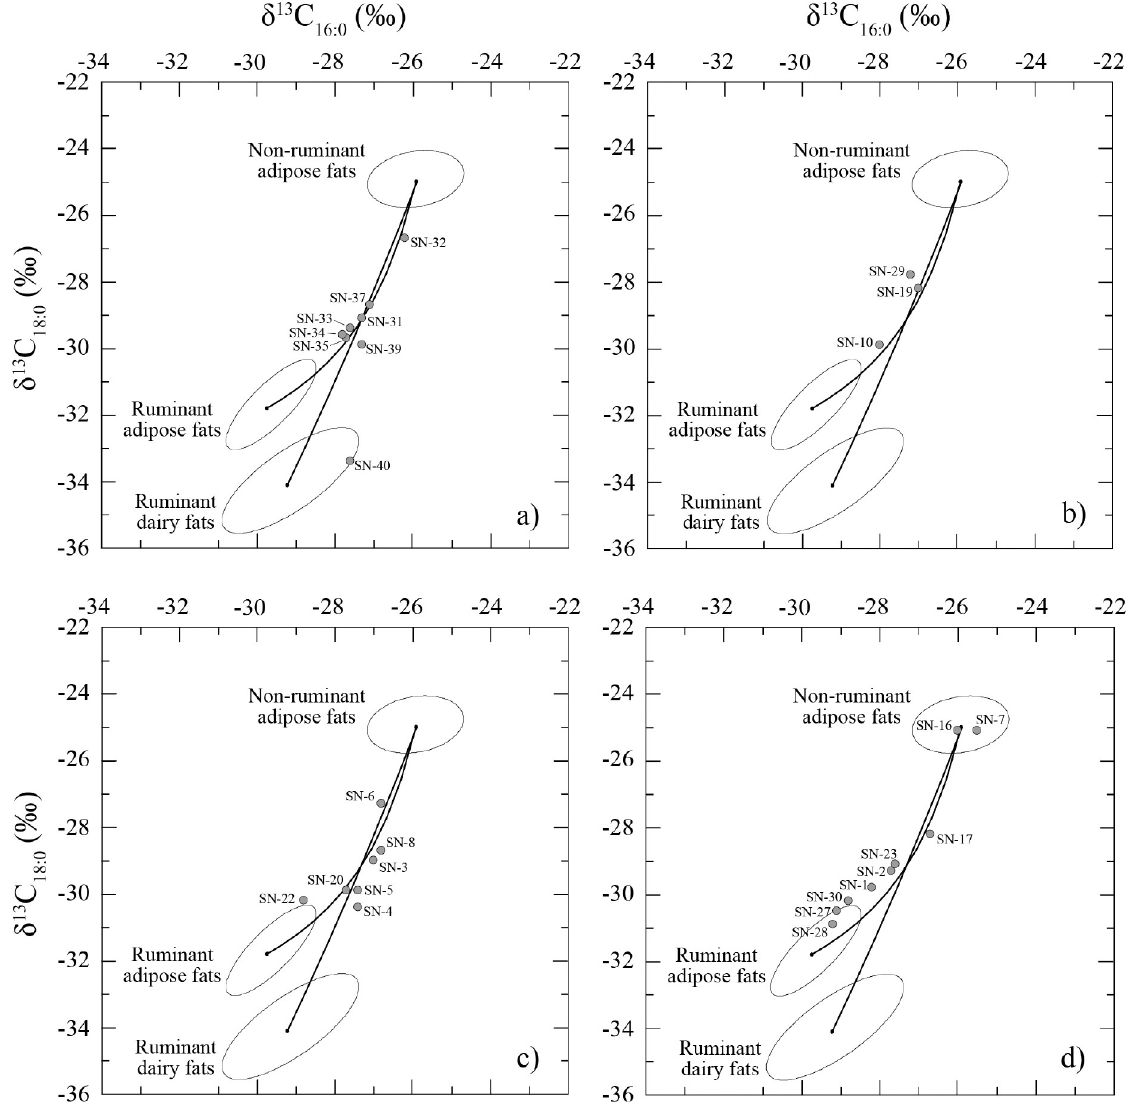
Fig 2. Scatter plots showing the δ 13 C values of C 16:0 and C 18:0 fatty acids prepared from total lipid extracts of the pottery. (A) mixing plot and (C) big delta plot of extracts from pre-Conquest sherds (Late Saxon Shelly ware c. AD 900–1050 and St Neots ware c. AD 925– 1050); (B) mixing plot and (D) big delta plot of extracts from post-Conquest sherds (Cotswold ware c. AD 1050–1250, and Oxford ware c. AD 1050–1250). The values of modern reference fats are represented by confidence ellipses (1 standard deviation). All δ 13 C values obtained for modern reference animal fats have been adjusted for the post-Industrial Revolution effects of fossil fuel burning, by the addition of 1.2‰ [25]. Lines connecting the ellipses represent theoretical δ 13 C values obtained through the mixing of these fats.